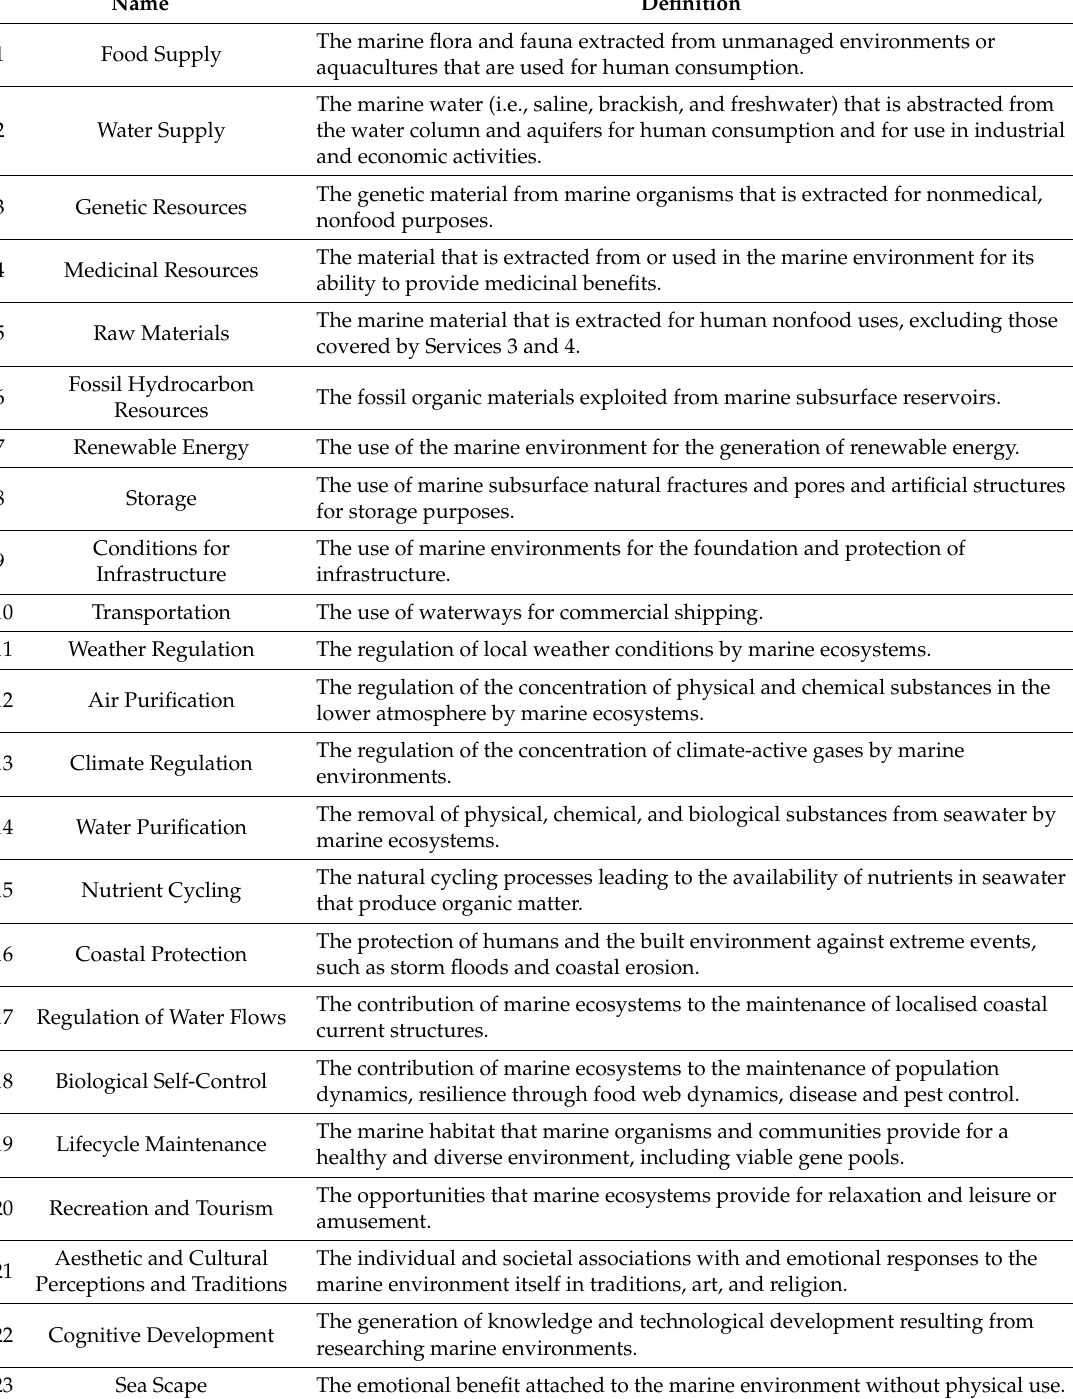
Table 1. Definition of relevant marine ecosystem services. The first column lists the names of the numbered marine ecosystem services (MarES); the second column provides definitions of each of the